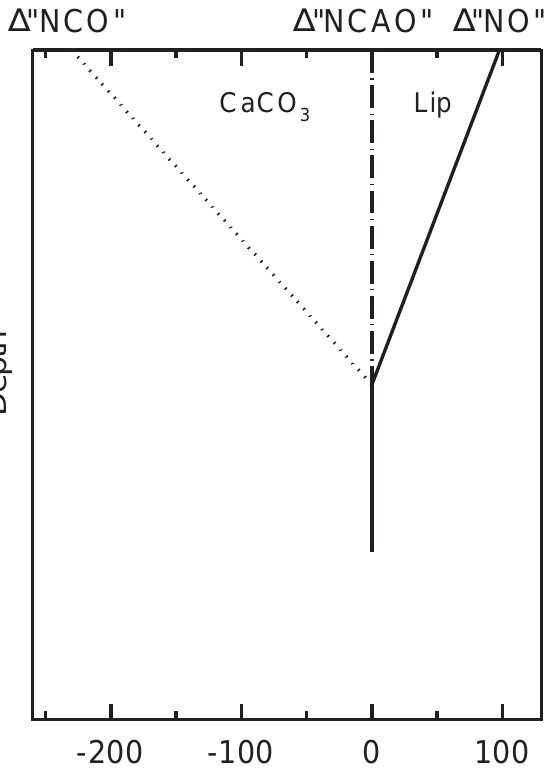
F IG . 7. – Theoretical plot of changes in the tracers “NCO” and “NO” during a coccolithophore bloom, assuming both calcite (CaCO scale formation and accumulation of lipids in the